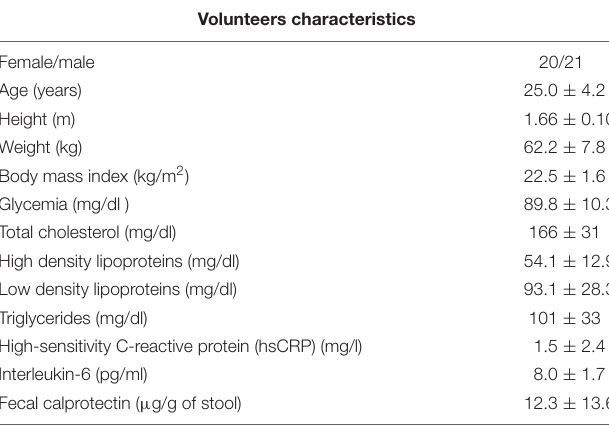
TABLE 1 | Anthropometric, biochemical and clinical data of the 41 Chilean volunteers (Means ± SD). Volunteers